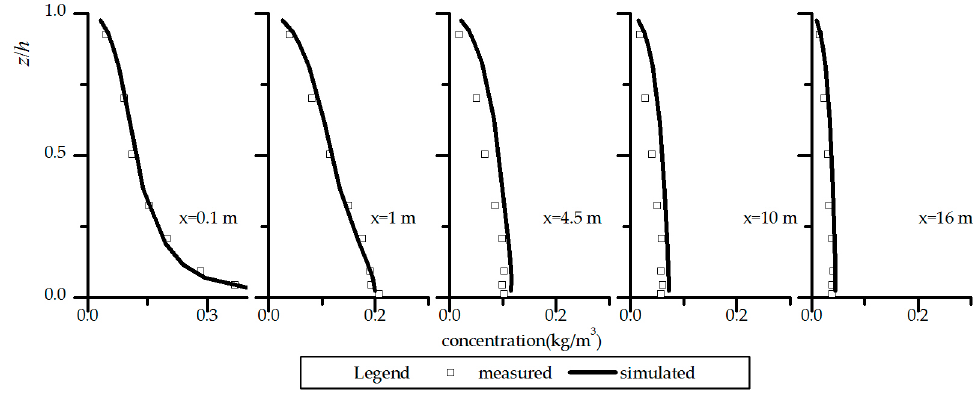
Figure 2. Non-equilibrium condition: calculated sediment concentration profiles in comparison with the experimental data.